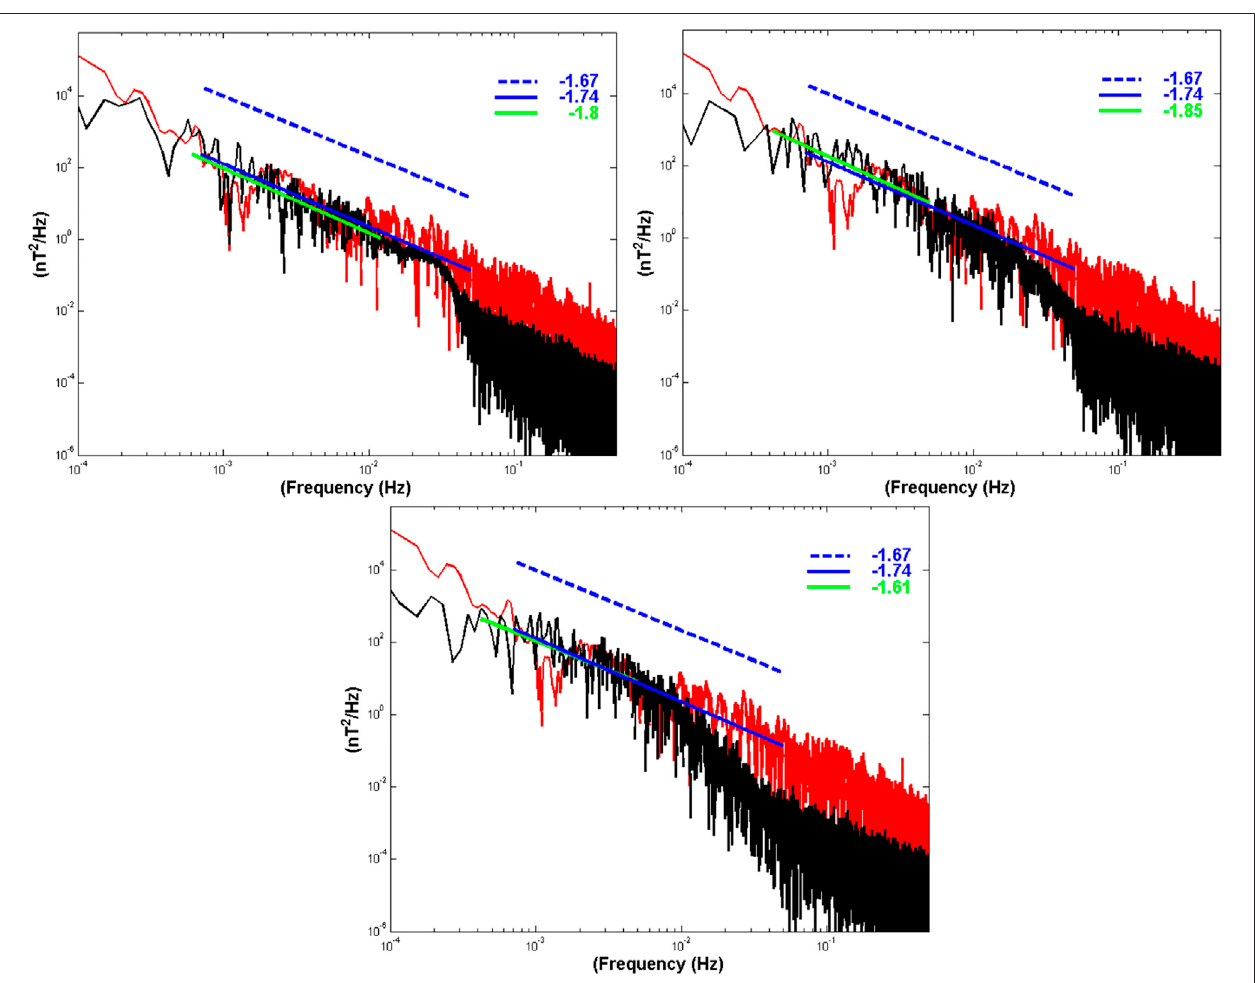
FIGURE9| ThepanelsshowPSDsfor B Z atthethreelocationsintheMHDsimulation.ValuesfromthesimulationareblackandatTHEMISP5observationsarered. The solid blue (green) lines are least squares fi ts in the inertial range for the data (MHD results). The dashed blue lines have the slopes of -5//3.